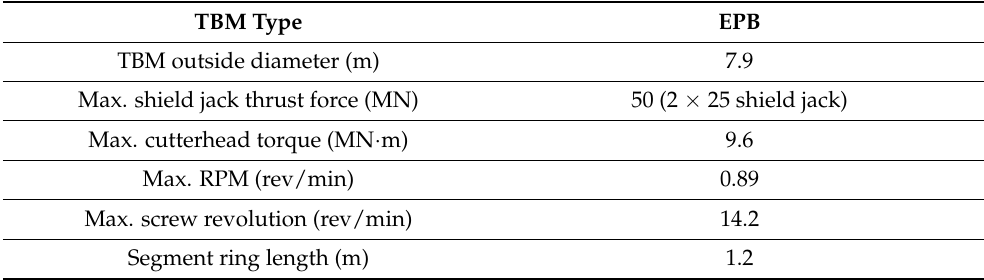
Table 3. Summary of TBM